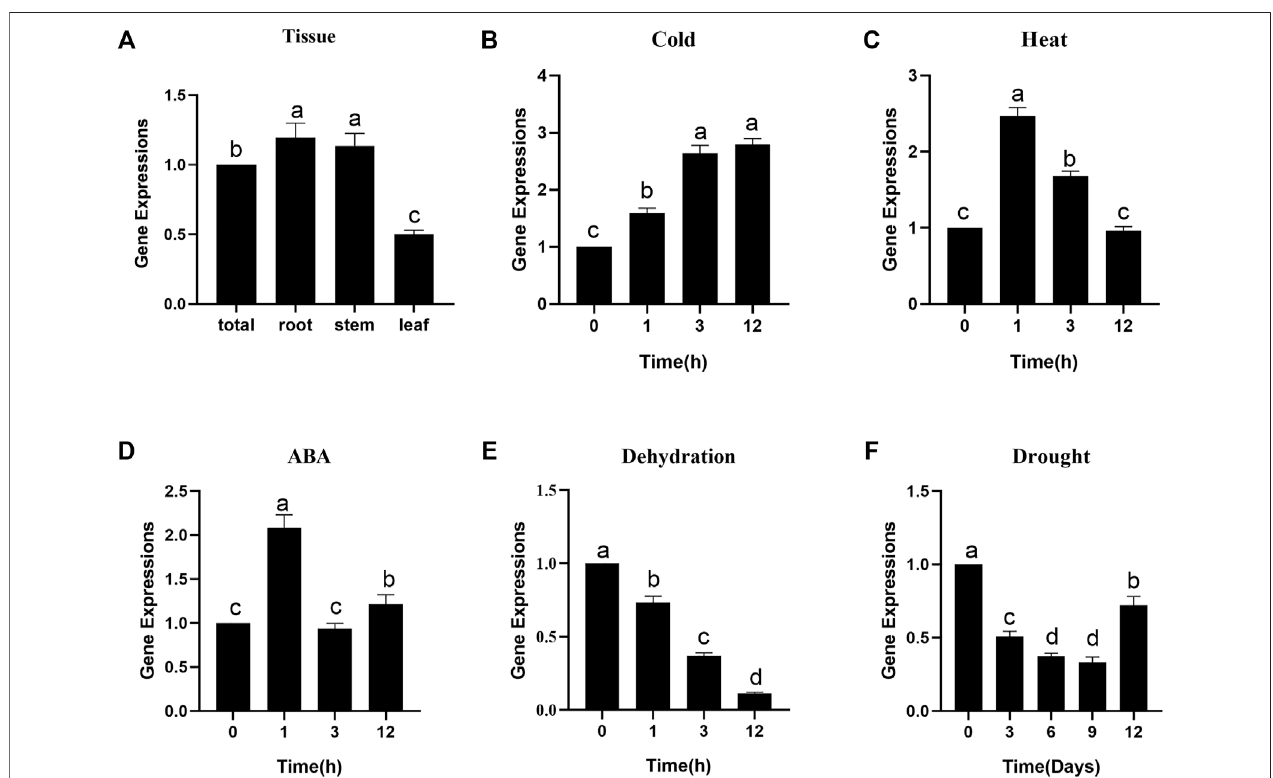
FIGURE 5 | The expression pattern of CiDUF1005 in Caragana intermedia . (A) The expression of CiDUF1005 roots, stems, leaves, and whole seedlings (total). (B – F) PatternofCiDUF1005 expressionunderdifferenttreatments,suchas4 ° C (B) ,42 ° C (C) ,and200 μ MofABA (D) ,dehydration (E) ,anddrought (F) .Differentletters indicate signi fi cant differences at p < 0.05 according to Duncan ’ s multiple range